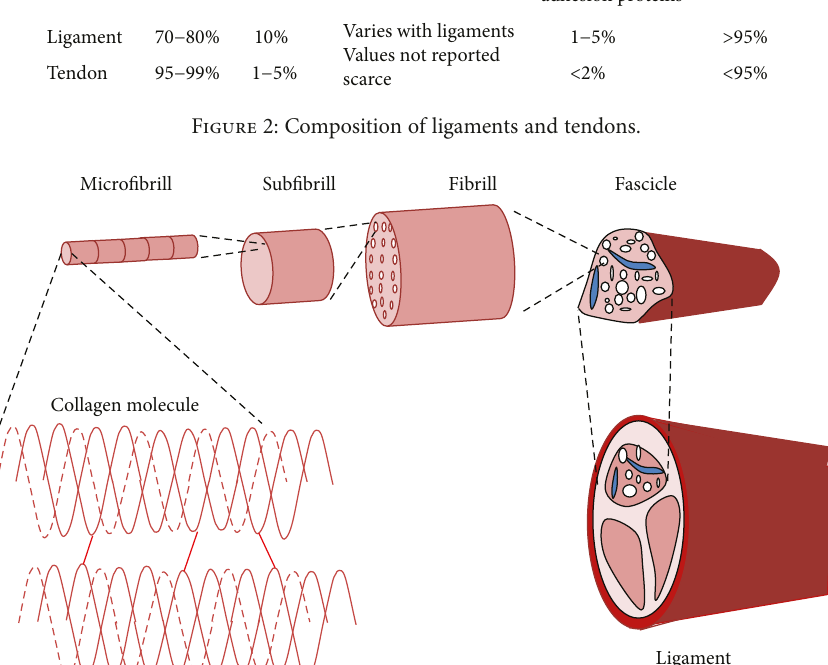
Figure 3: Schematic showing the hierarchy involved in the ligament